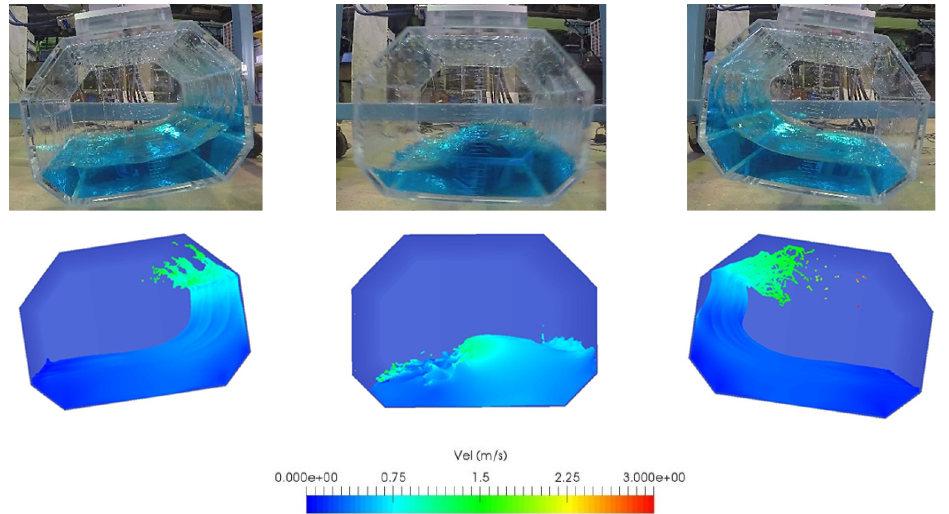
Figure 8. Free surface evolution under roll oscillations at t = 11.0 seconds, 11.2 seconds, and 11.4 seconds with a 25% filling ratio.